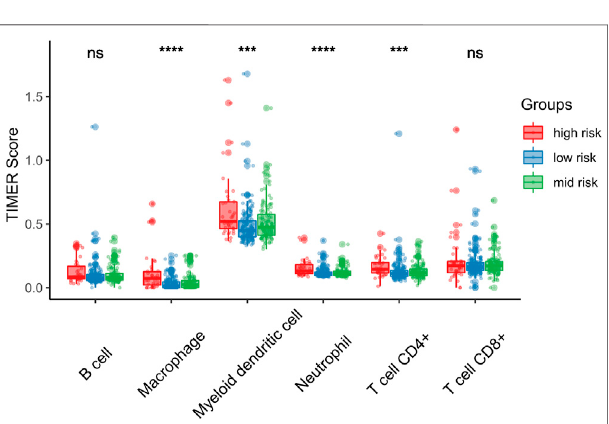
FIGURE 7 | Association between risk score and immune in fi ltration. Macrophage, Myeloid dendritic cell, Neutrophil and CD4+T cell are signi fi cantly high in high risk score groups. * p < 0.05; ** p < 0.01; *** p < 0.001.